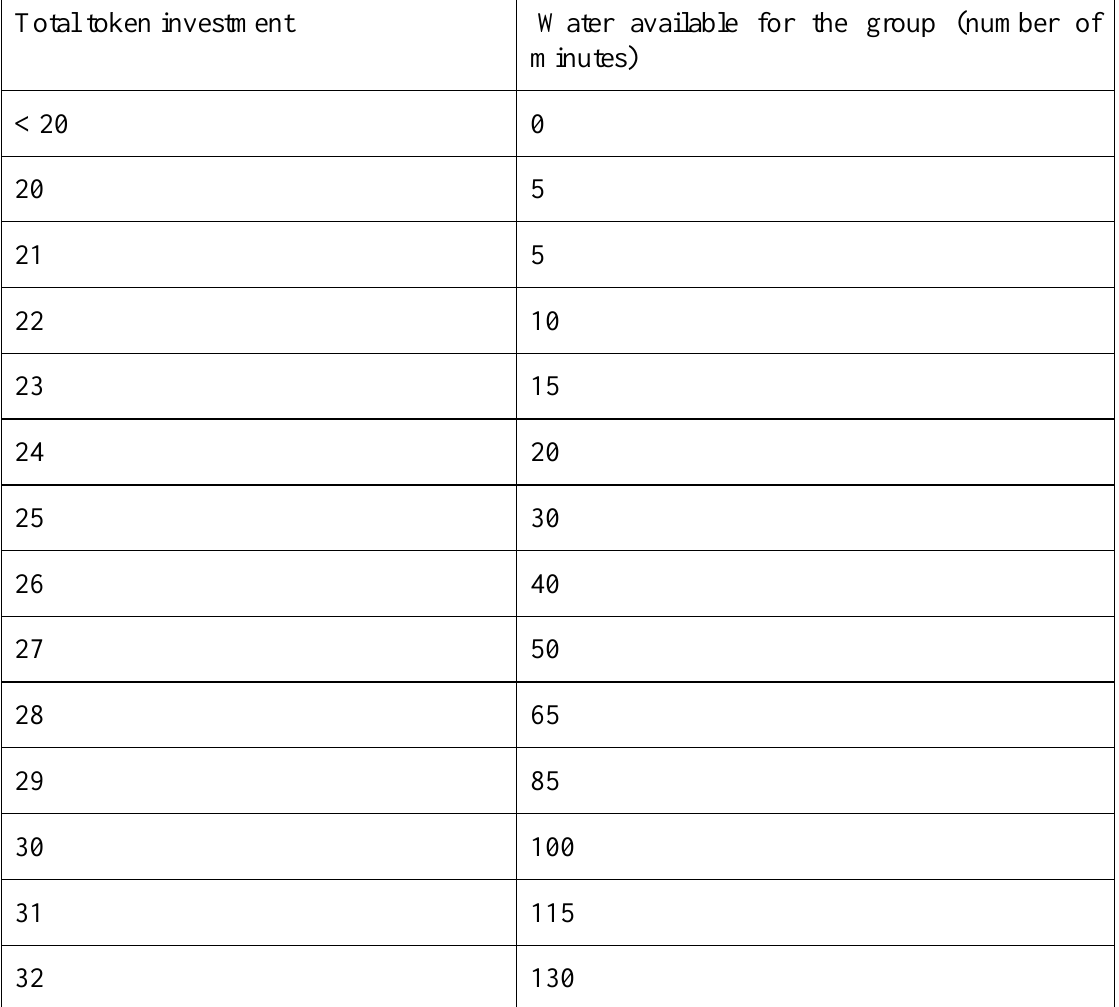
Table A.6.1. Investment and